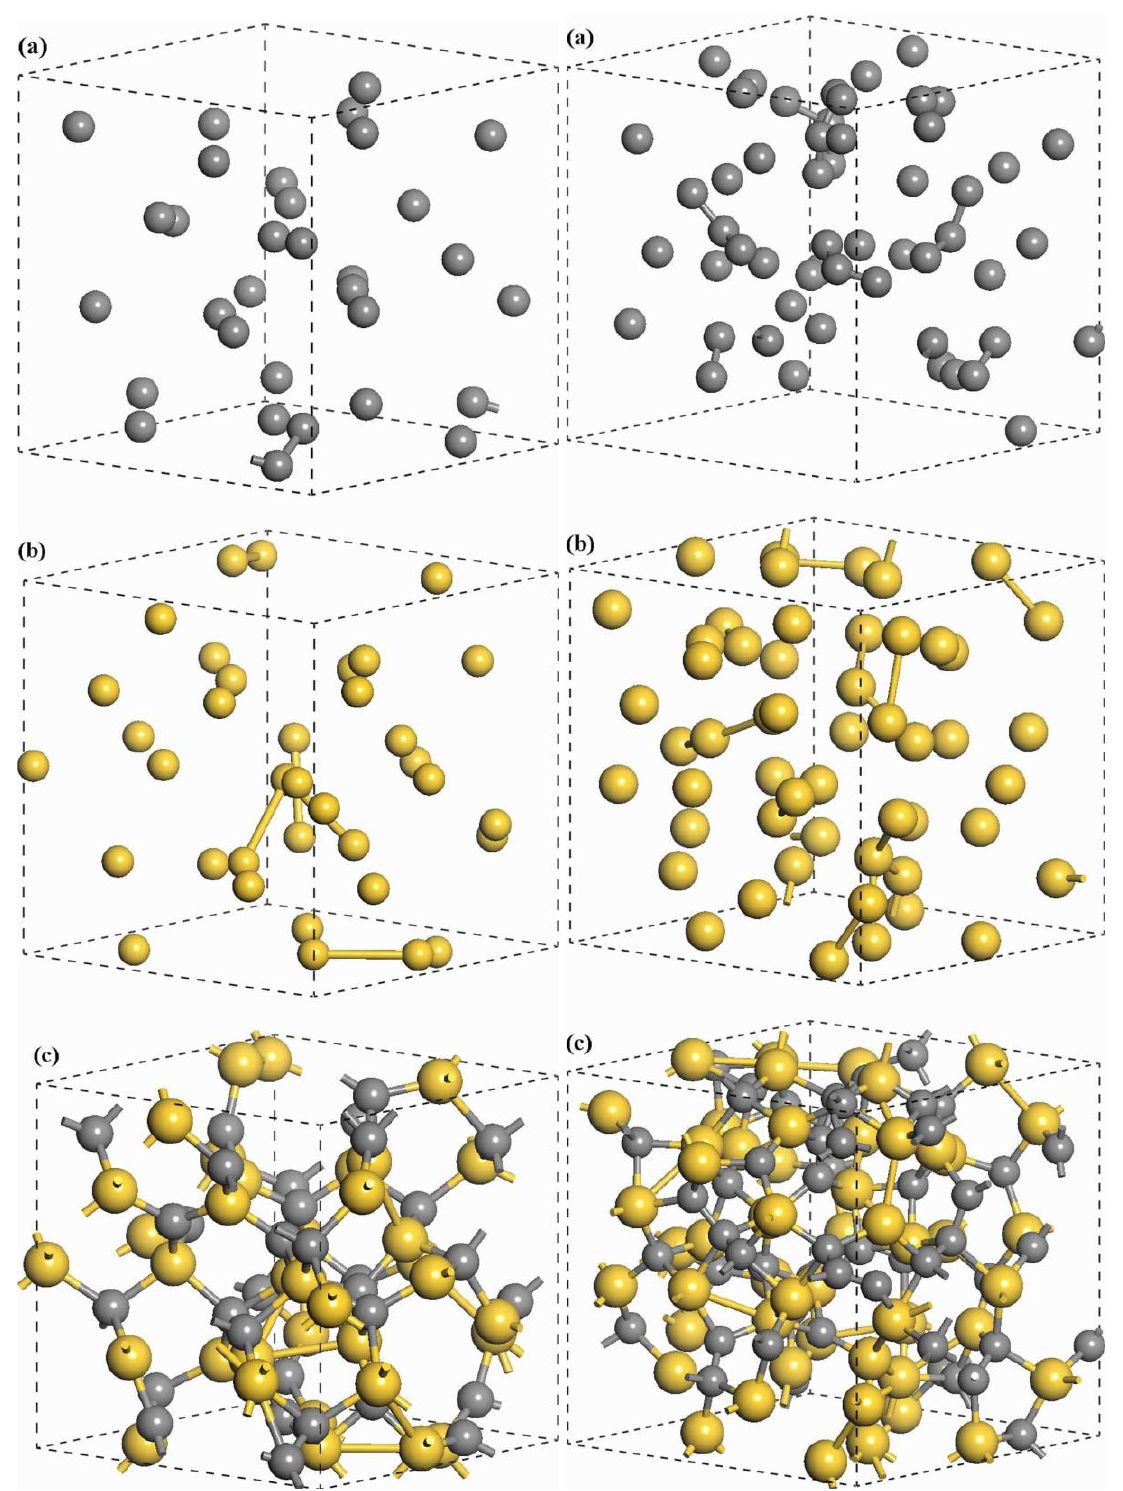
Figure 21. Structures of the amorphous silicon carbide generated by F AST (left, 64 atoms) and DM OL 3 (right, 108 atoms). ( a ) Carbon structure; ( b ) Silicon structure; ( c ) Silicon carbide